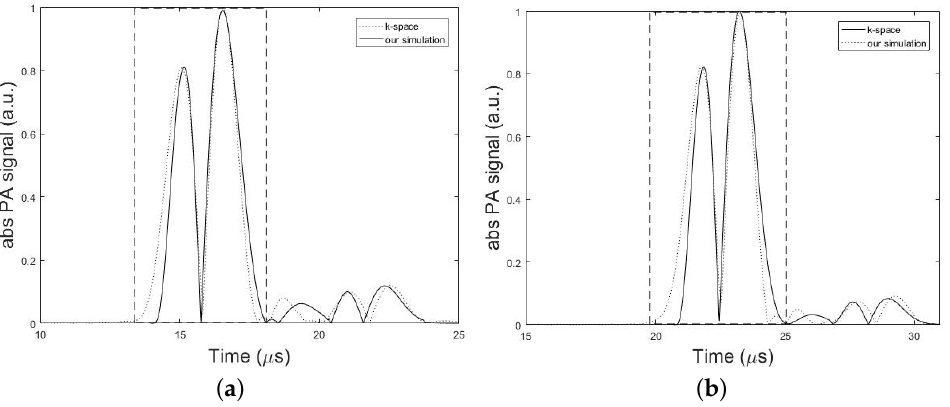
Figure 5. Numerical validation of the proposed method versus the k-space algorithm. Absolute PA signal profiles simulated by k-space algorithm (dotted line) and our simulation method (solid line). Dashed rectangles show the main bipolar pulse of the simulated PA signal. In these simulations, the setup in Figure 2 with the parameters, h = 7 mm, k = 10 mm, r 0 = 1 mm, r d = 0.025 inch, and T = 5 cm is used. ( a ) Minimum error of 0.11% obtained for d = 1.7 cm. ( b ) Maximum error of 0.25% obtained for d = 2.7